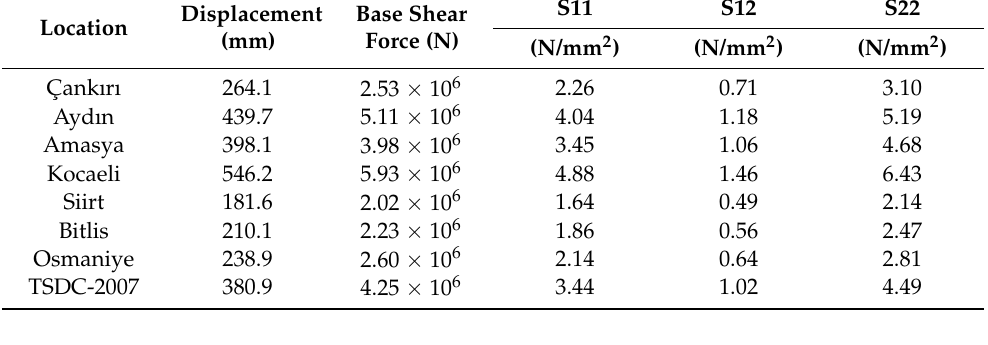
Table 13. Comparison of the results obtained for different settlements.